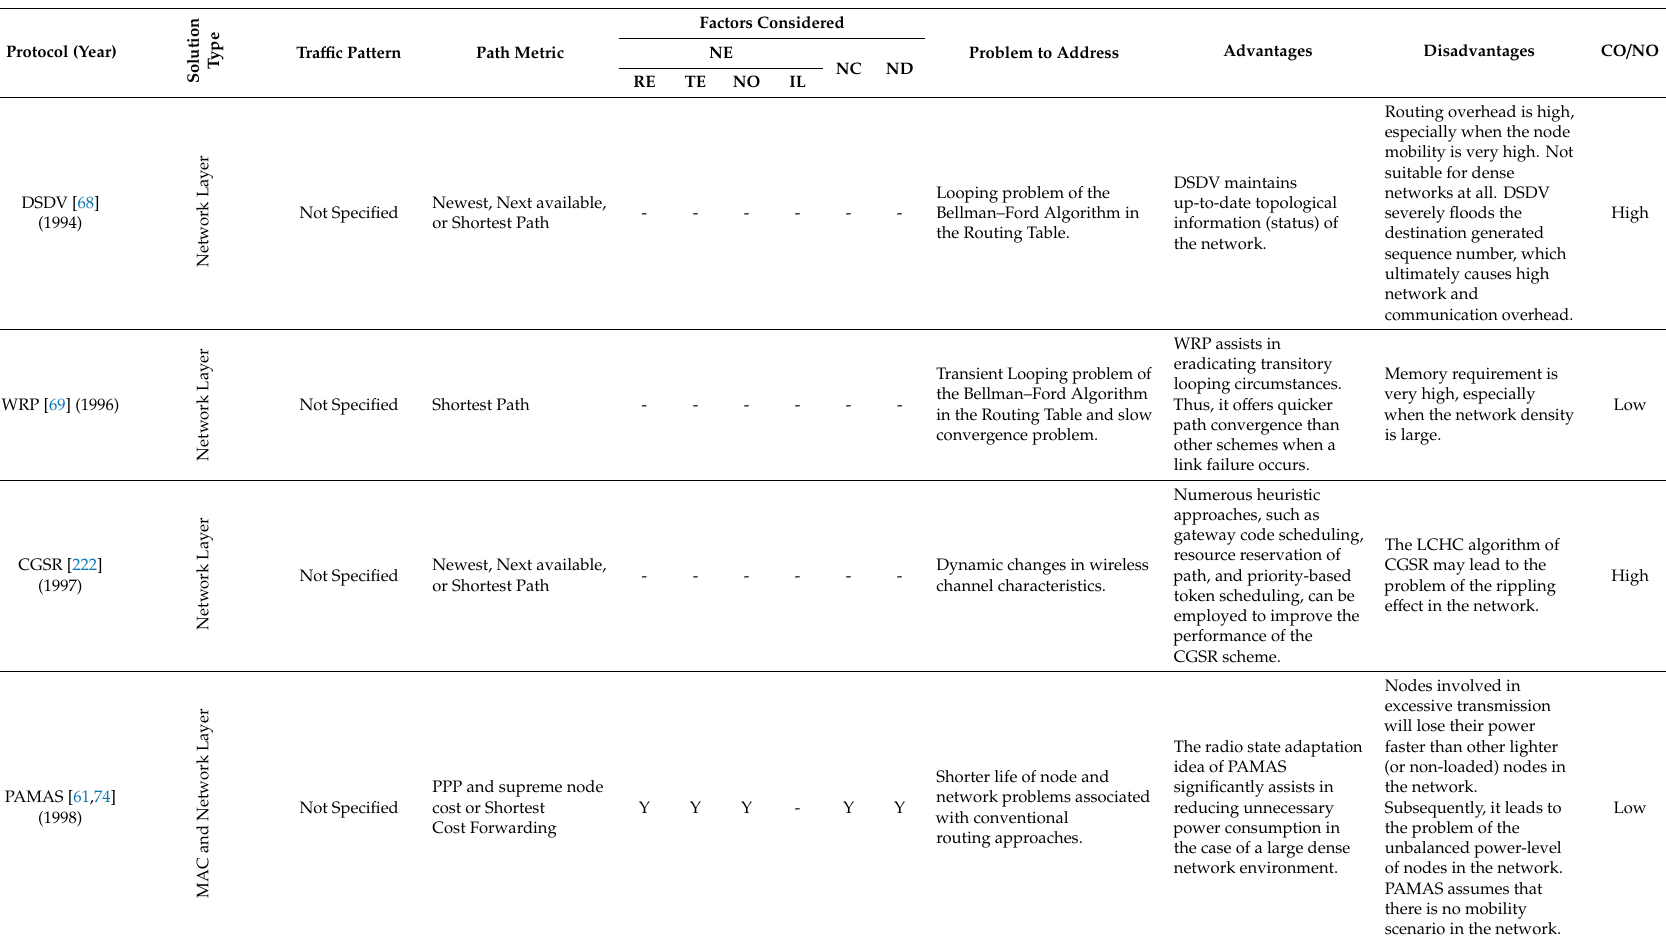
Table 5. A qualitative comparison of the important power-e ffi cient proposals and some conventional routing